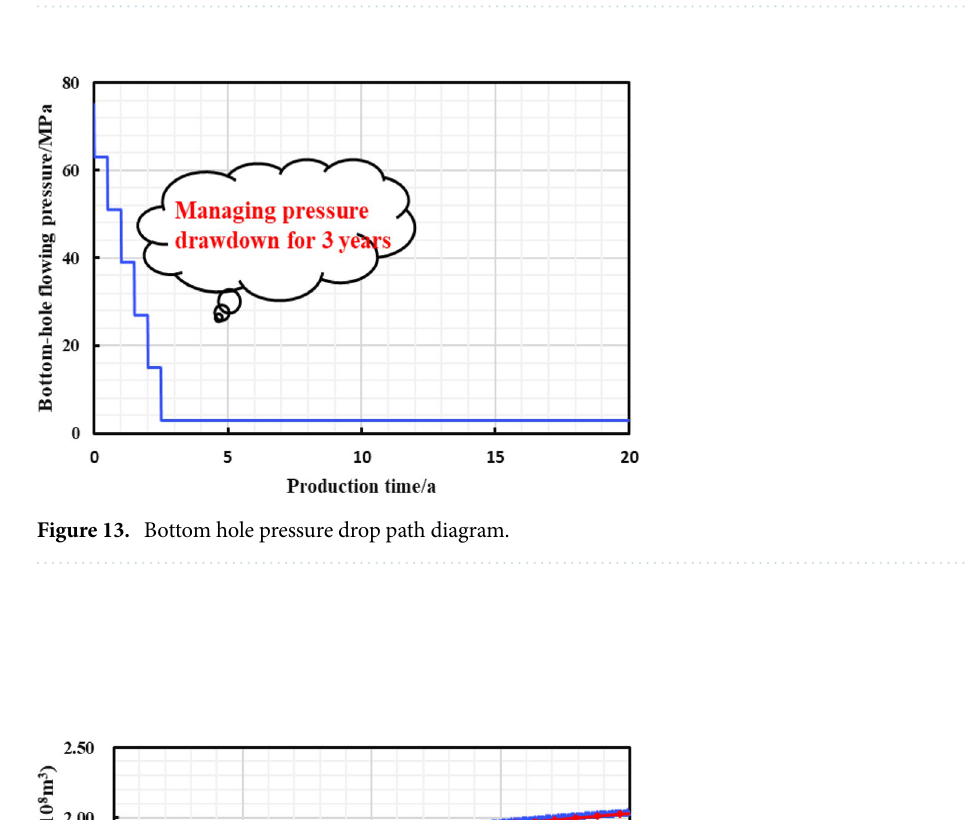
Figure 12. The relationship between gas compressibility and deviation factor and pressure.